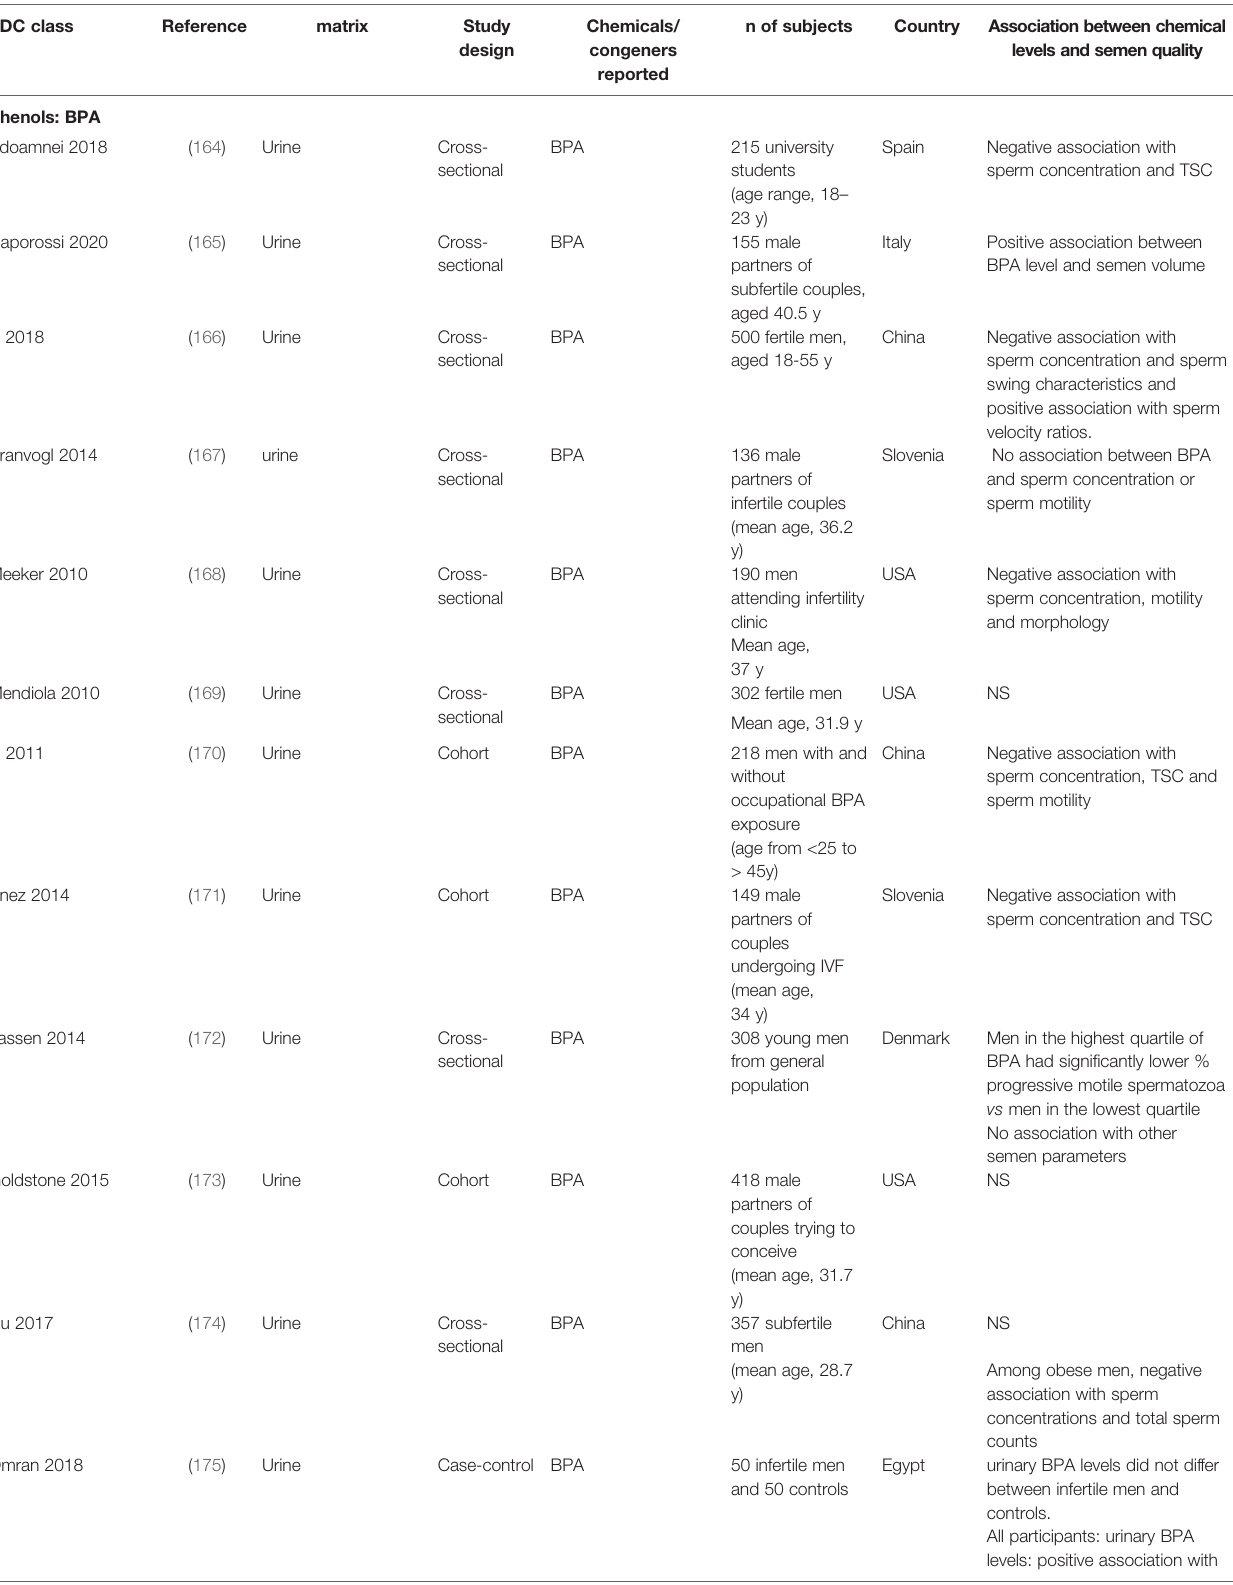
TABLE 5 | Studies on postnatal endocrine disrupting chemical exposure and associations with semen